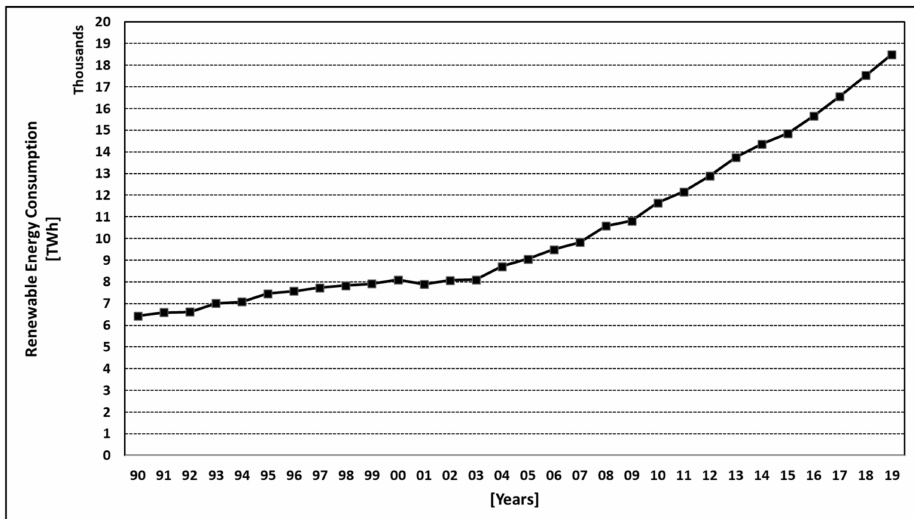
Figure 2. Global renewable energy consumption for primary